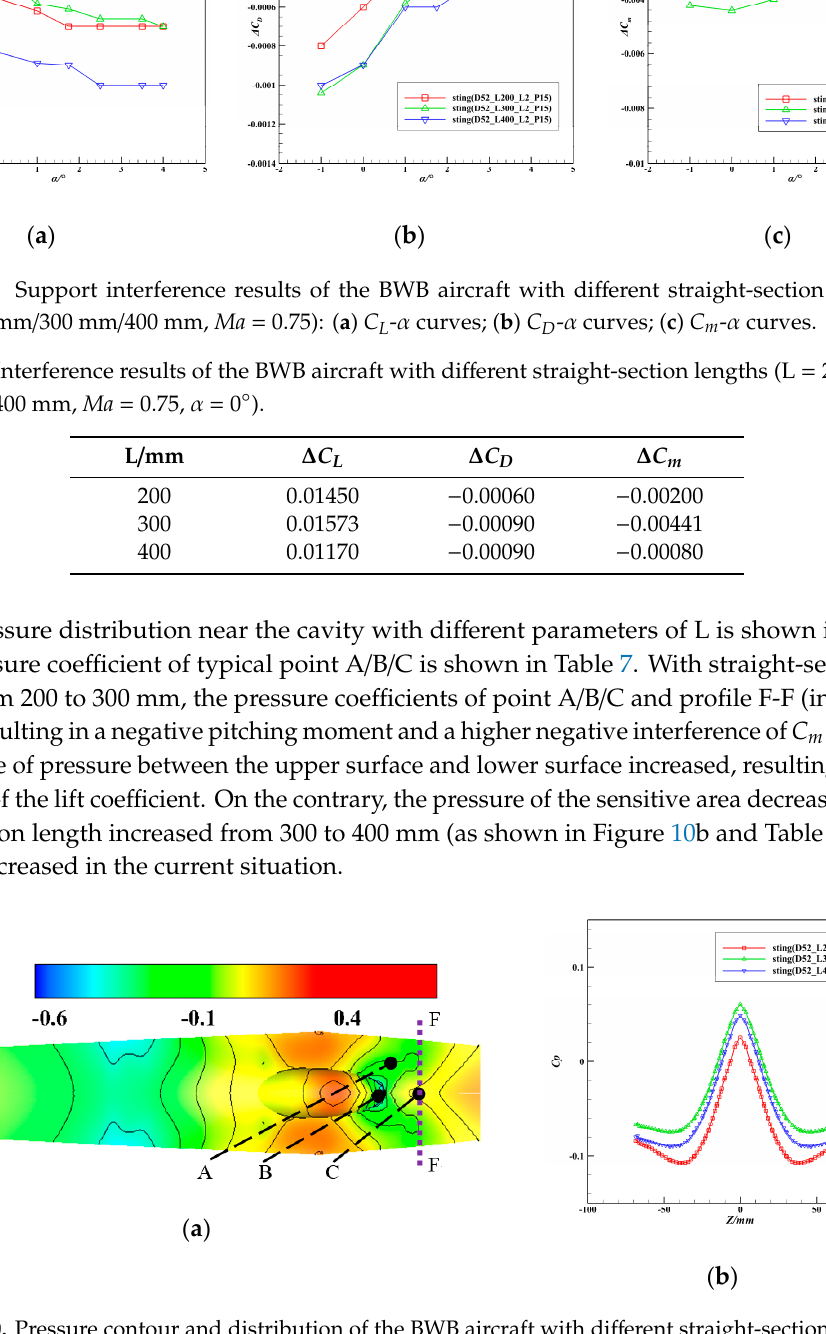
( b ) ( c ) Figure 11. Support interference results of the BWB aircraft with different first-section lengths (H = L2 − 100 mm/L2/L2 + 100 mm, Ma = 0.75): ( a ) C L - α curves; ( b ) C D - α curves; ( c ) C m - α curves.